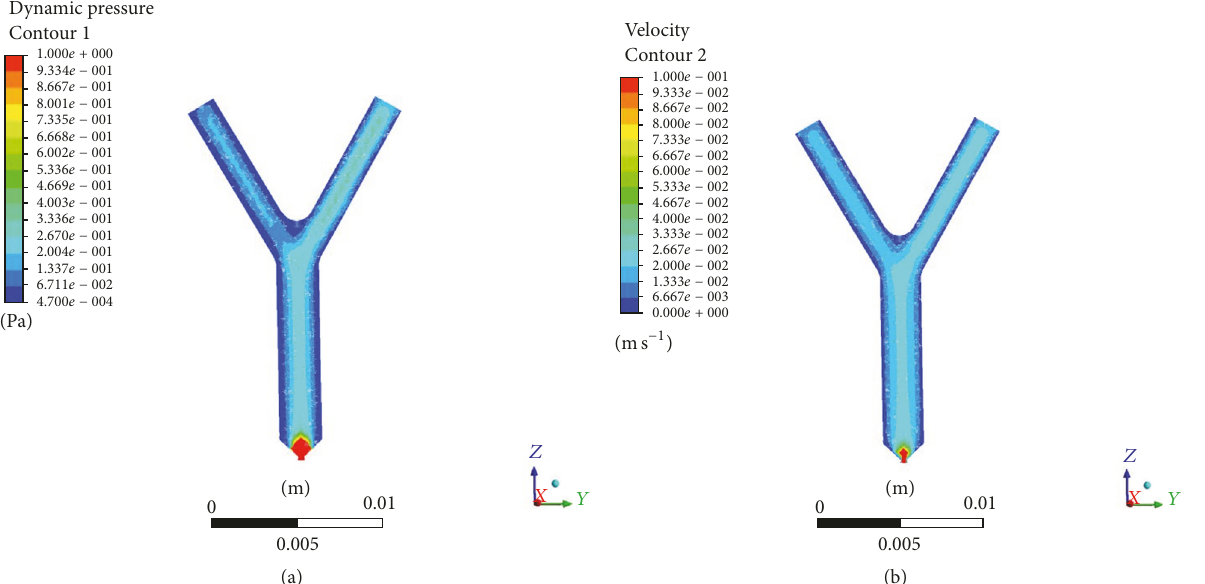
Figure 12: Pressure and velocity contours in the steady state: (a) pressure contours; (b) velocity